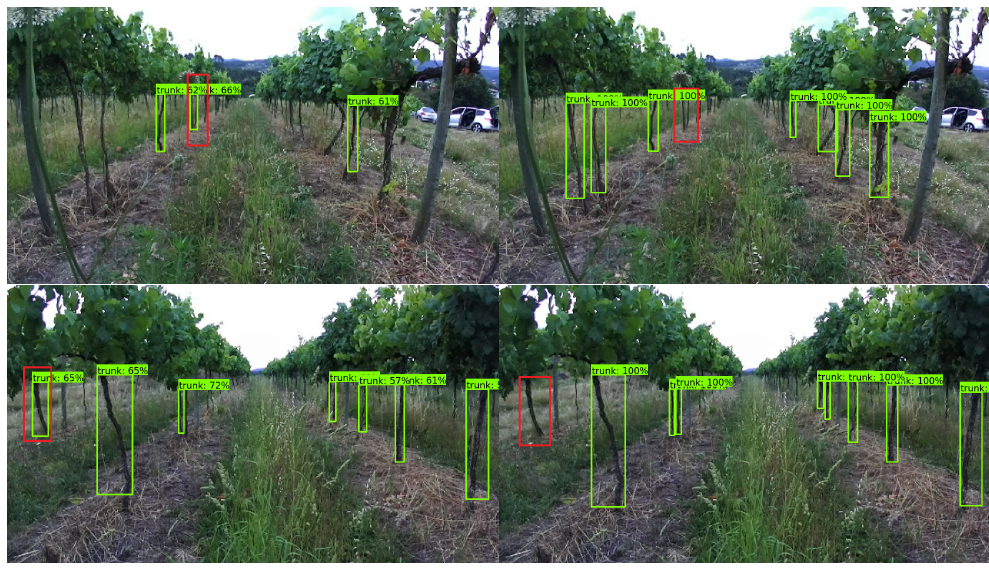
Figure 14. The left images are the detection results of the model, and the left side is the ground truth. The model has found the trunks in the image that are not marked as tree trunks.